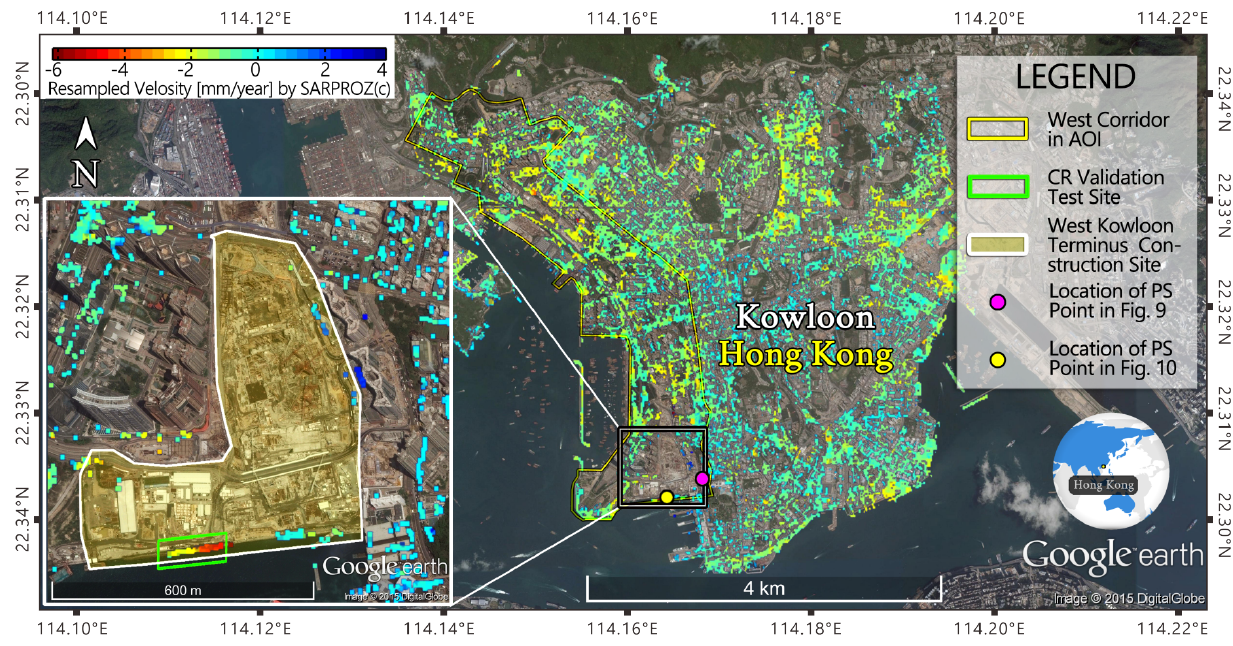
Figure 7. The annual LOS velocity of the linear displacement map for PS points that have a height within the region of [ − 5,5] meters located in the Hong Kong urban